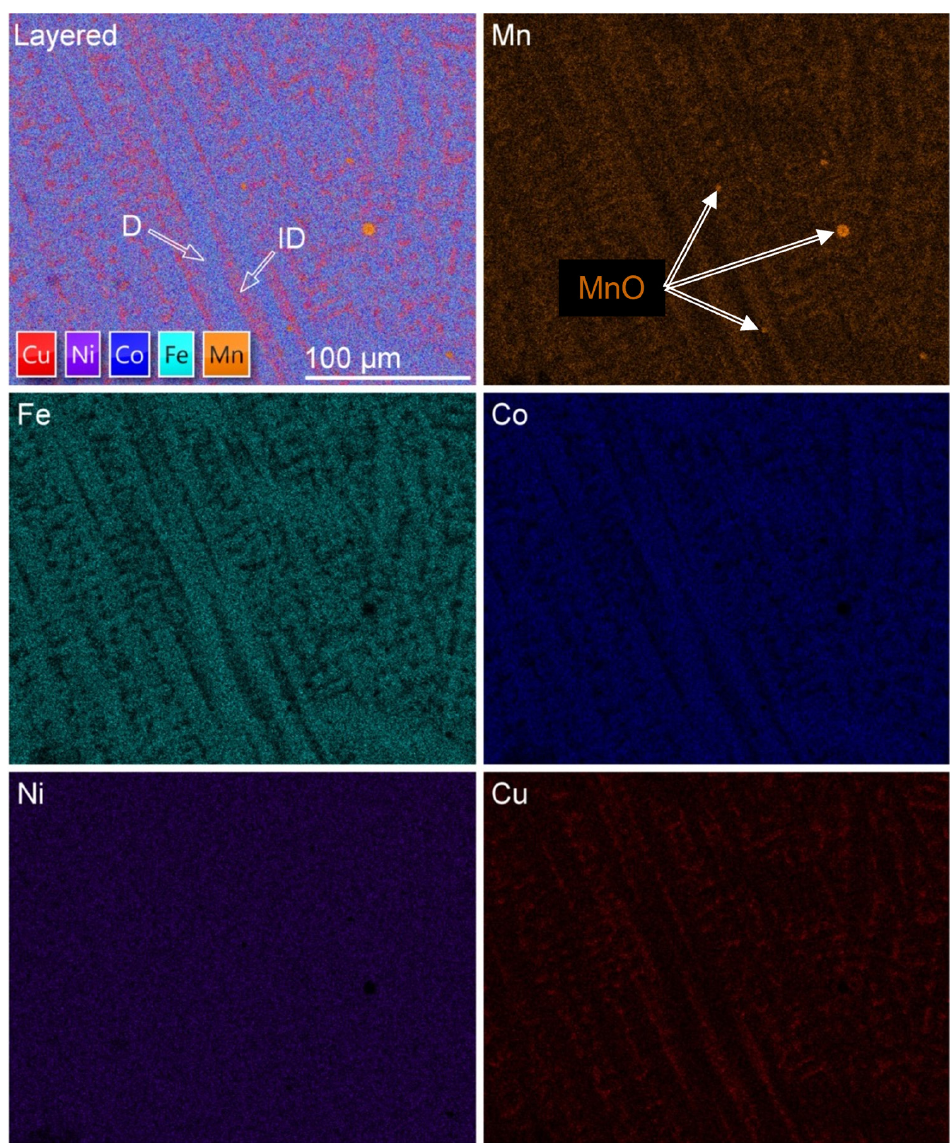
Figure 12. Layered EDS map and constituent elemental maps from an arc-melted, Mn 17 Fe 21 Co 24 Ni 24 Cu 14 alloy cross-section. The solidified microstructure is dendritic, with Fe/Co and Cu/Mn-enriched dendritic and interdendritic regions, respectively. The composition of each region is presented in the Table 7. Table 7. Compositions of dendritic (D) and interdendritic (ID) regions measured by EDS.